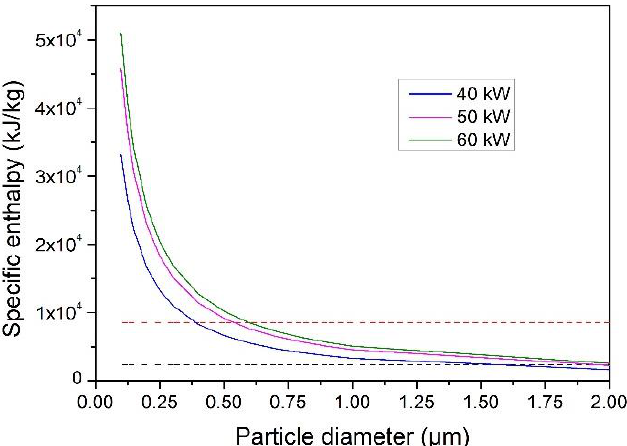
Figure 8. Effect of the torch net power on the specific enthalpy of particles stored over their travel inside the plasma torch (from injection point to nozzle exit); the horizontal red dotted line corresponds to the YSZ evaporation enthalpy (8561 kJ/kg) and black dotted lines to the YSZ melting enthalpy (2386 kJ/kg). 40 SLPM of argon, 8 SLPM of hydrogen, chamber pressure: 100 Pa.